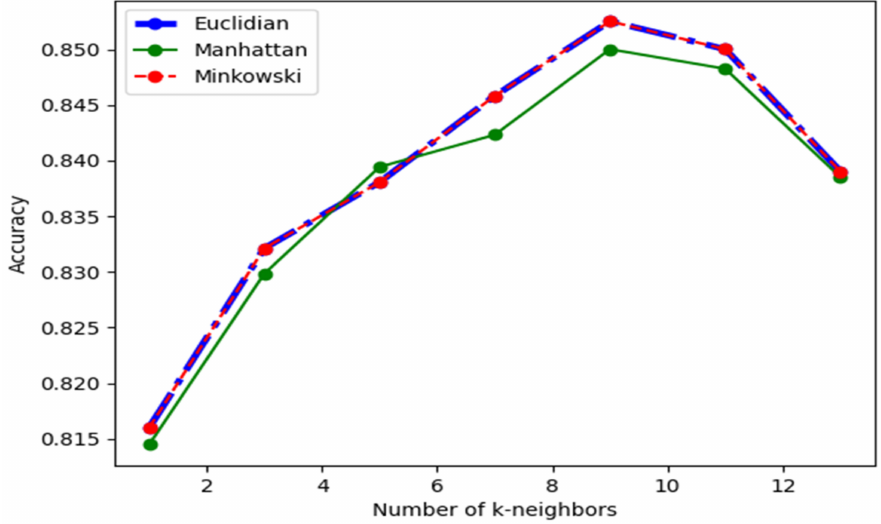
Figure A2. Accuracy of different distance measures over the number ( n ) of k-neighbors used for the k-NN